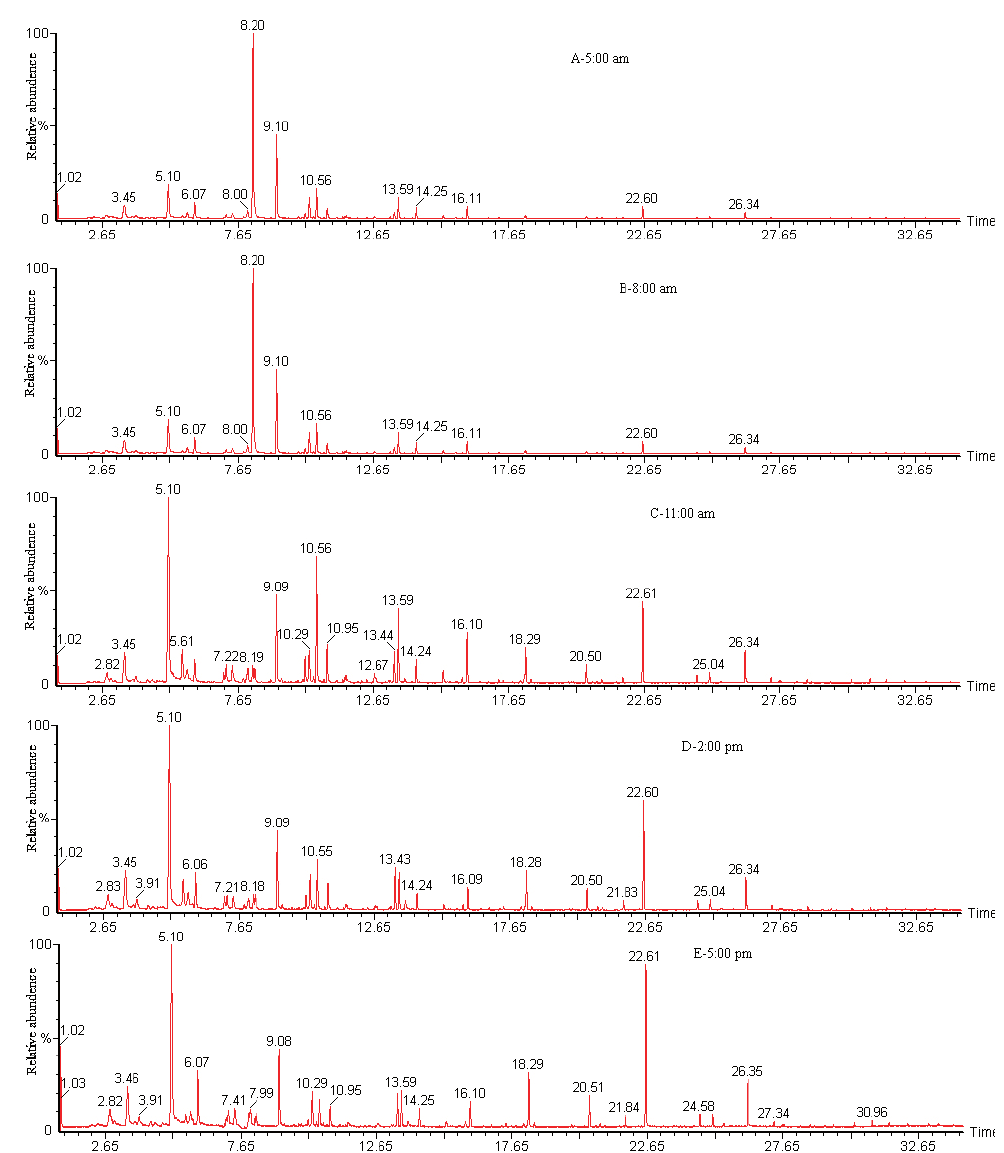
Fig. 1: GC/MS total ion current chromatograms of volatile compounds from four seasons rose in rainy